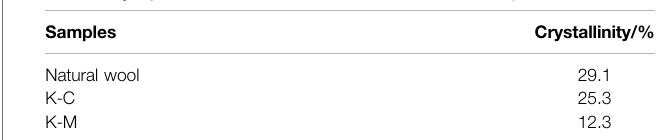
TABLE 4 | Crystallinities of natural wool and wool keratin